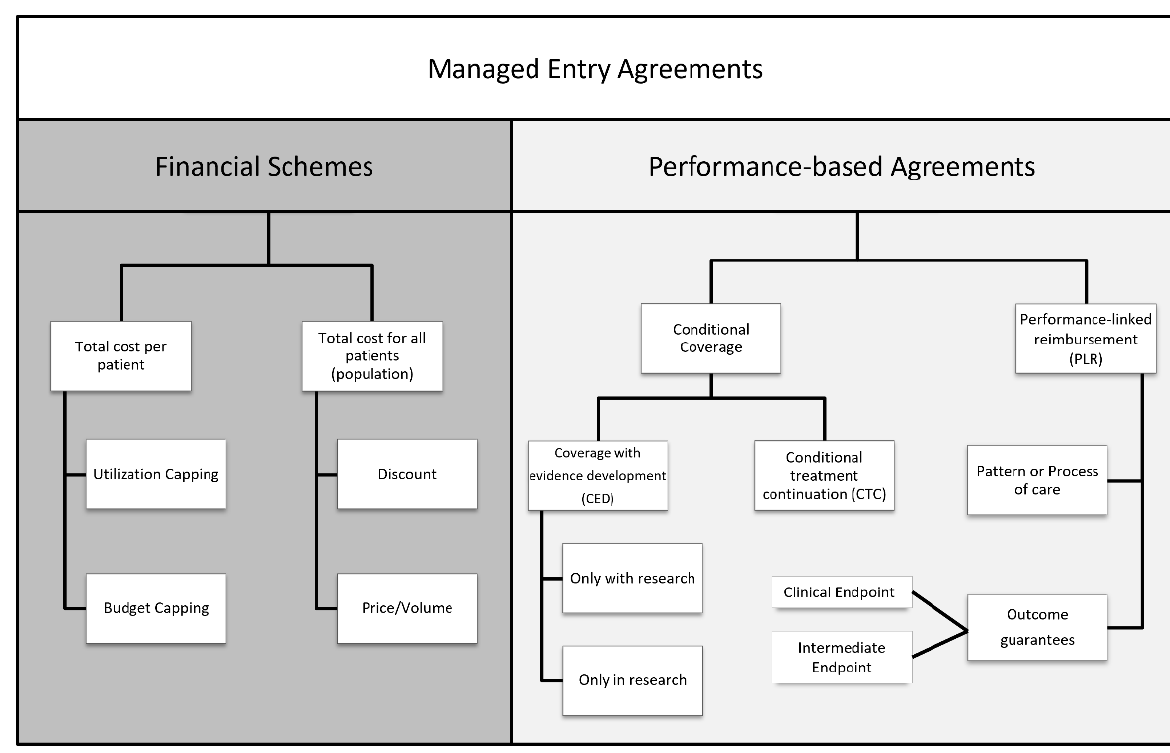
Figure 6. The taxonomy of Managed Entry Agreements (MEAs) is divided into two main forms: Financial schemes and performance-based agreements.